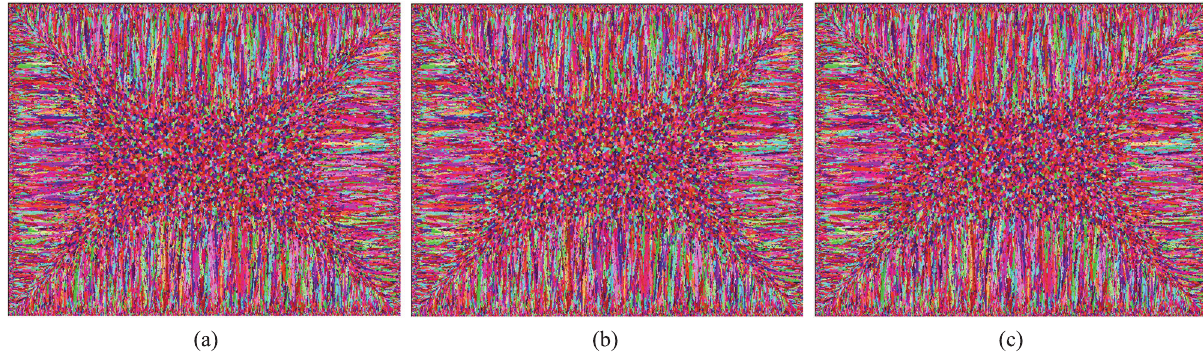
Fig. 5: The simulated solidification structures of 82B steel under different secondary cooling water intensities: (a) 1.1 m/min, 0.9 L/ kg,